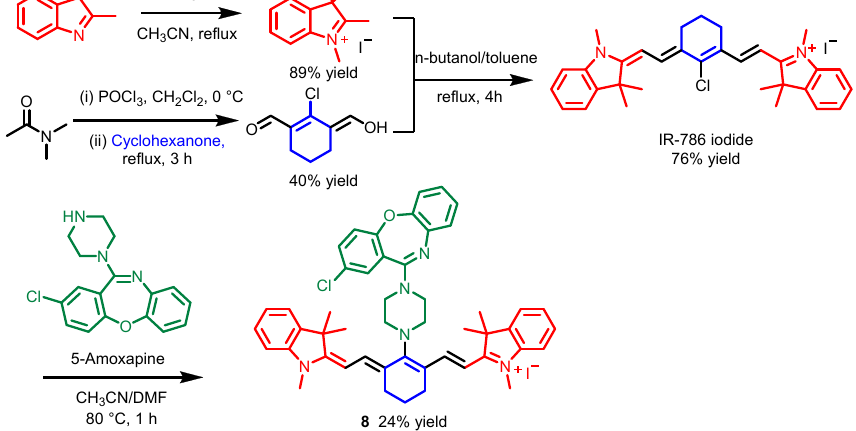
Scheme 7. Synthesis of dye 8 .